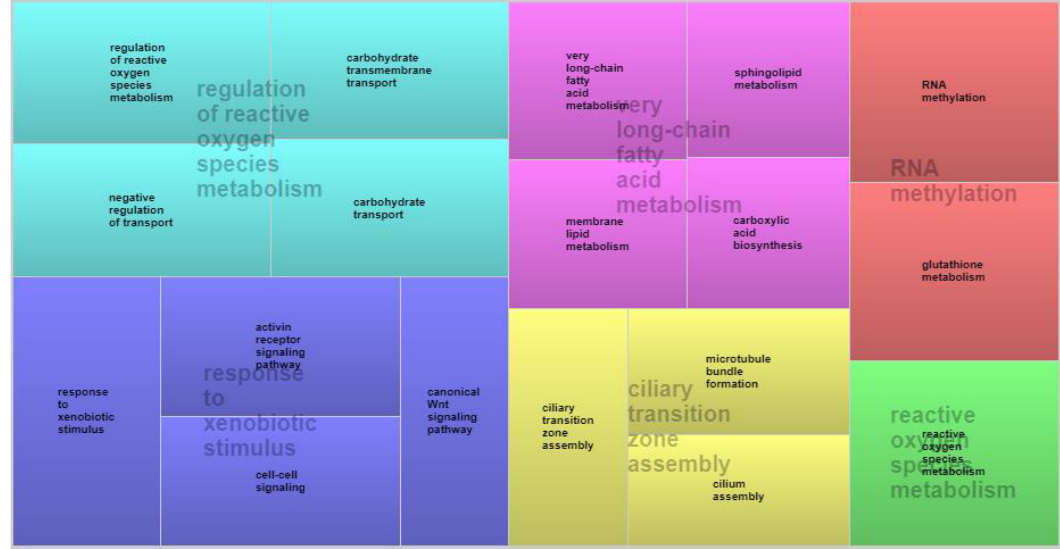
Figure 3. Analysis of biological processes co-associated with precocity evaluated based on visual scores in Nellore cattle.